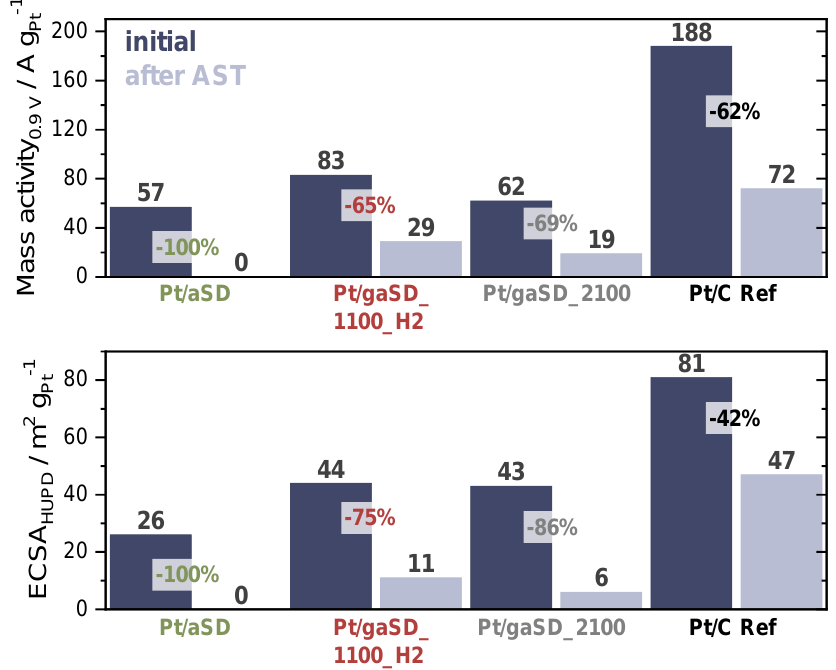
Figure 7. Mass activities at 0.9 V RHE and ECSA HUPD for catalysts Pt/aSD, Pt/gaSD_1100_H2, Pt/gaSD_2100 and Pt/C ref before (initial) and after the AST (0.6 − 1.5 V RHE , 5000 cycles). Averaged values of two electrochemical measurements are shown, for single values please check Figure S1 in the Supplementary Material.